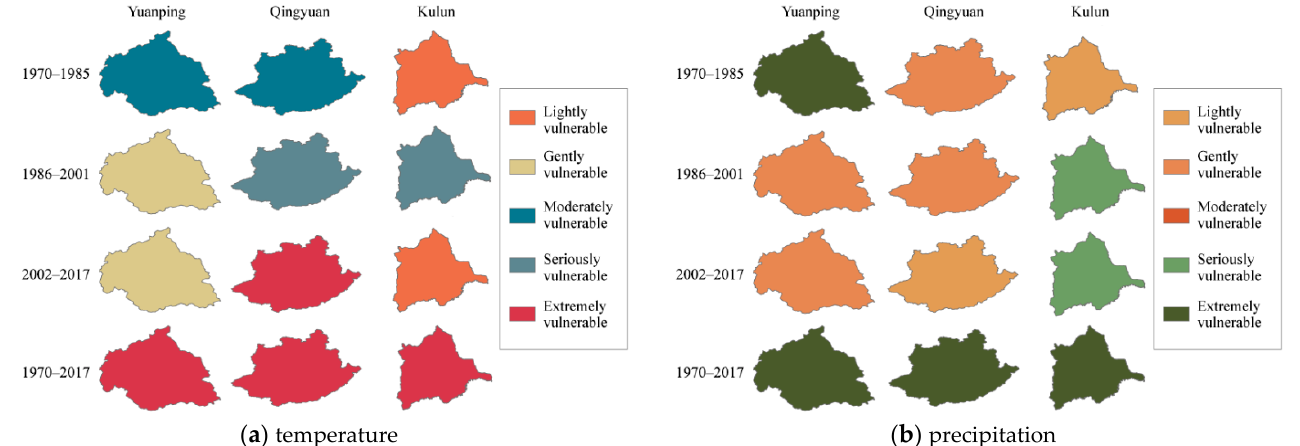
Figure 5. Vulnerability assessment results of Yuanping, Qingyuan, and Kulun.